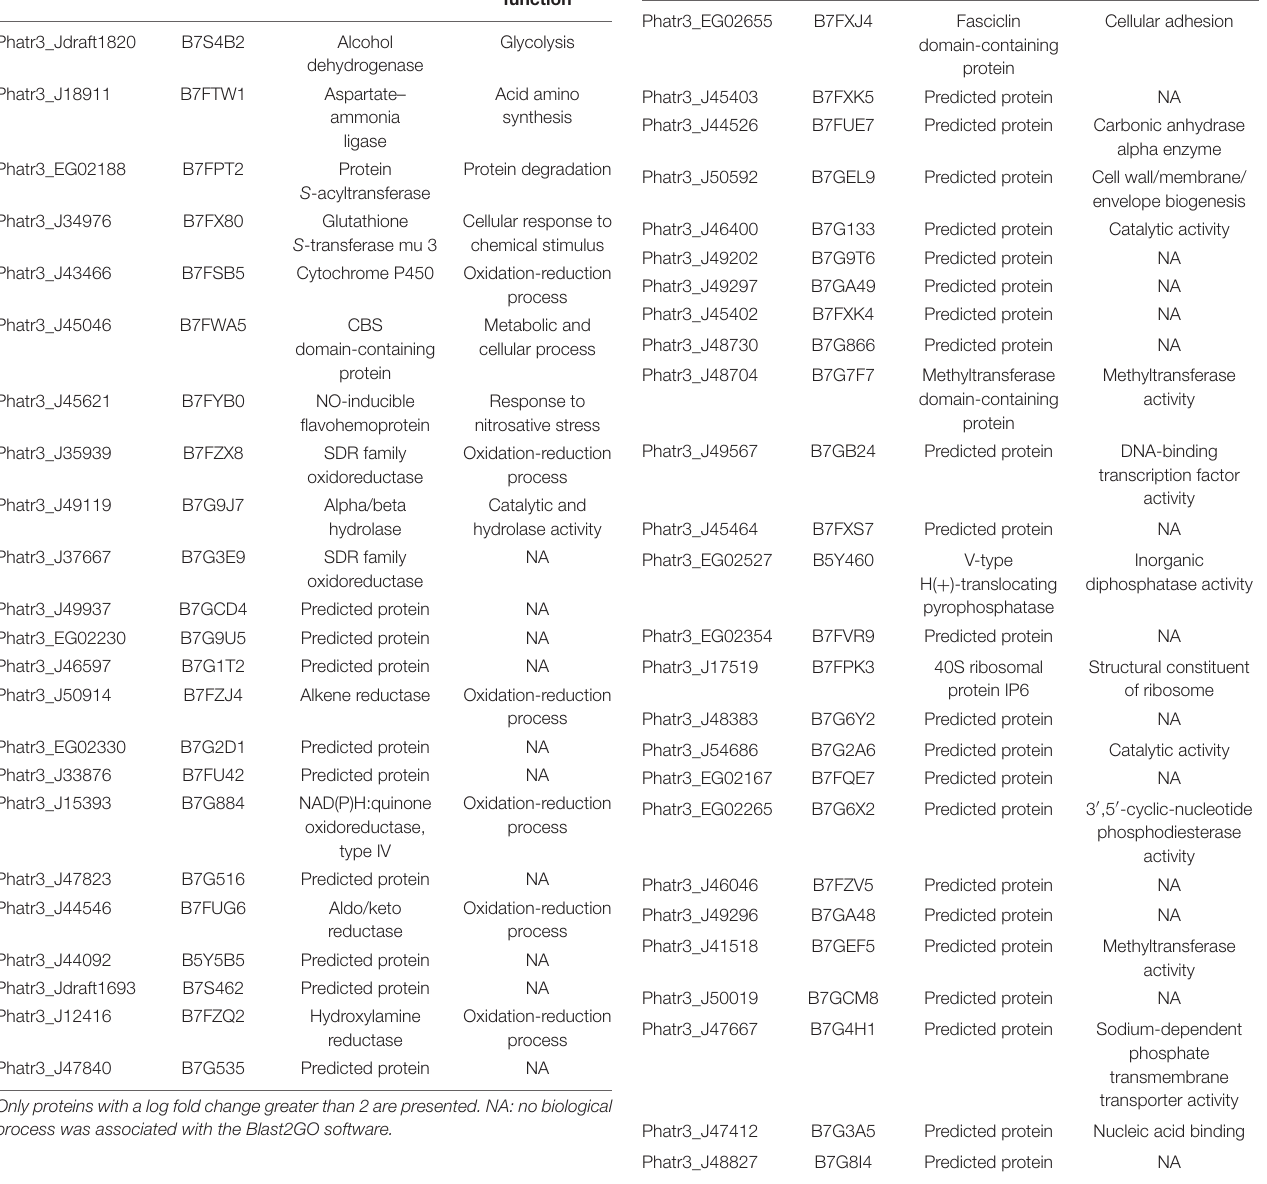
TABLE 3 | Biological process in which oval morphotype down-regulated proteins are involved. SeqName